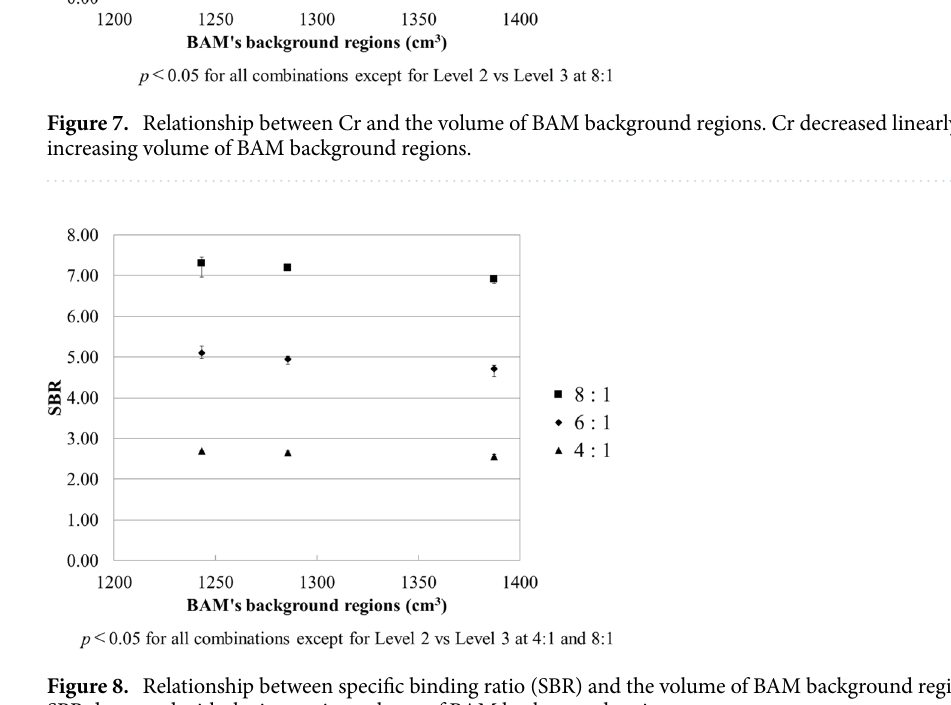
Figure 8. Relationship between specific binding ratio (SBR) and the volume of BAM background regions. The SBR decreased with the increasing volume of BAM background